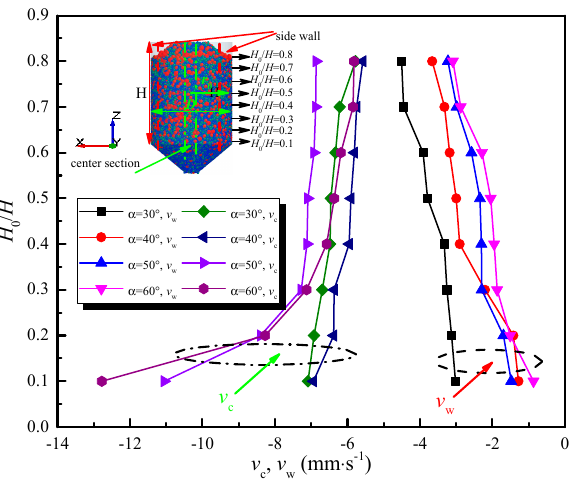
Figure 17. The variation in v c , v w with sinter layers for different half hopper angles.